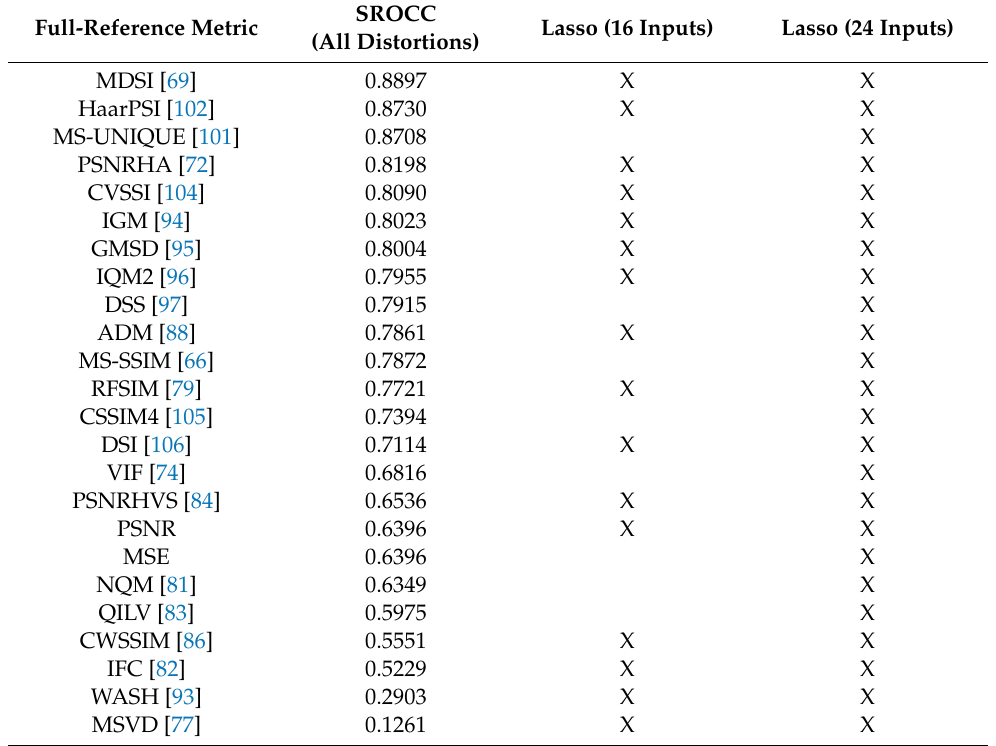
Table 5. Elementary metrics used by the neural network for 16 and 24 inputs with SROCC values. Full-Reference